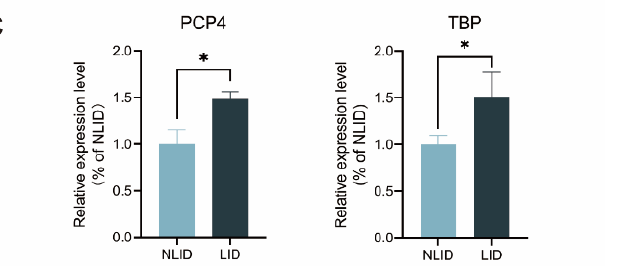
Figure 5. Dual-luciferase reporter assay and target genes expression. ( A ) Wild-type (WT) and mutated-type (MT) sequences of the putative binding sites between rno-Rsf1_0012 and rno-miR-298- 5p. ( B ) Dual-luciferase reporter assays were performed to validate the association of rno-Rsf1_0012 and rno-miR-298-5p. Compared with the NC mimics, rno-miR-298-5p significantly reduced the luciferase activity of the WT reporter, while rno-miR-298-5p did not affect the luciferase activity of the MT reporter. ( C ) PCP4 and TBP in LID group were significantly increased in LID group ( n = 6) compared with NLID group (n = 6). * p < 0.05, *** p < 0.001.